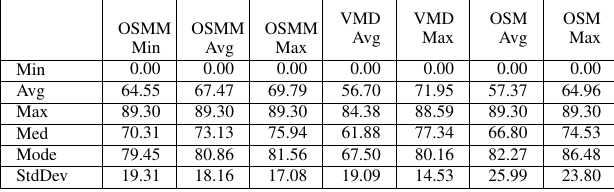
Table 2: Variation in Elevation Values for the Individual Datasets - Entire Test Area